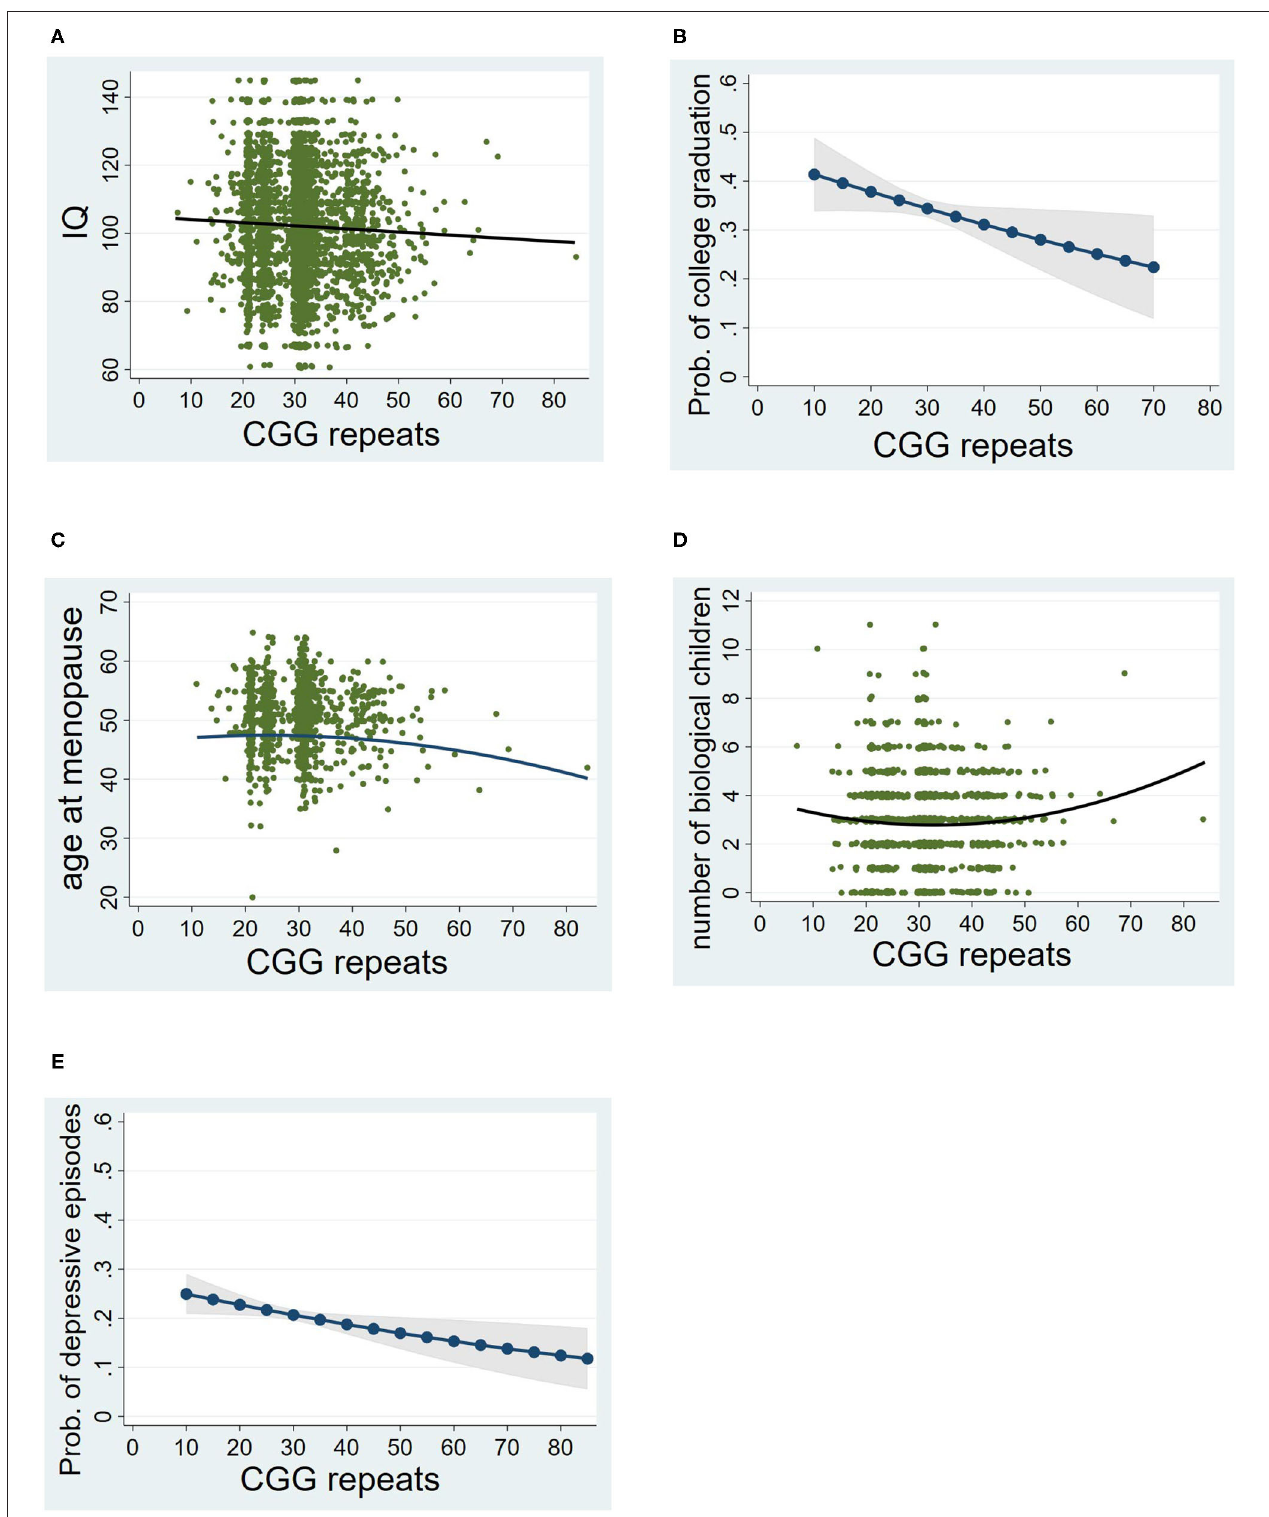
FIGURE 2 | Associations between CGG repeat lengths and phenotypes. (A) Linear association with IQ. (B) Linear association with college graduate (males only). (C) Curvilinear association with age at menopause (females only). (D) Curvilinear association with the number of biological children (females only). (E) Linear association with episodes of clinical depression. For (A) , (C) , and (D) , a scatterplot with the best fitted line are shown. For (B) and (E) , predicted probability of the phenotype by CGG repeat lengths are presented; Prob, predicted probability.